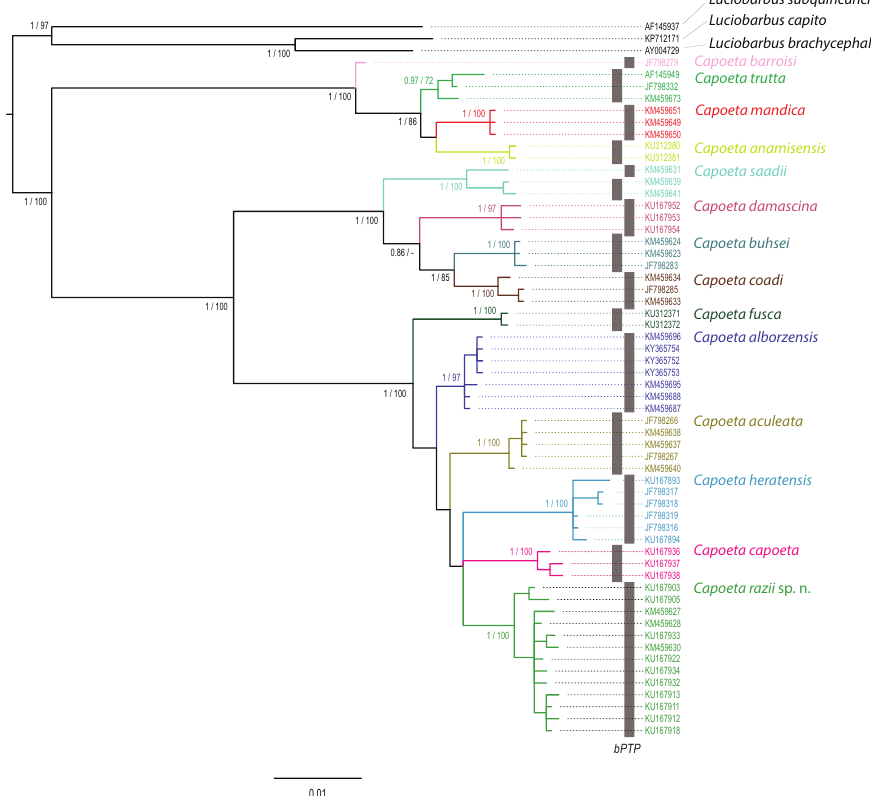
Figure 2. Capoeta genus; Values at nodes correspond to BI posterior probability/ML bootstrap. Grey bars represent the species delimitations performed with bPTP